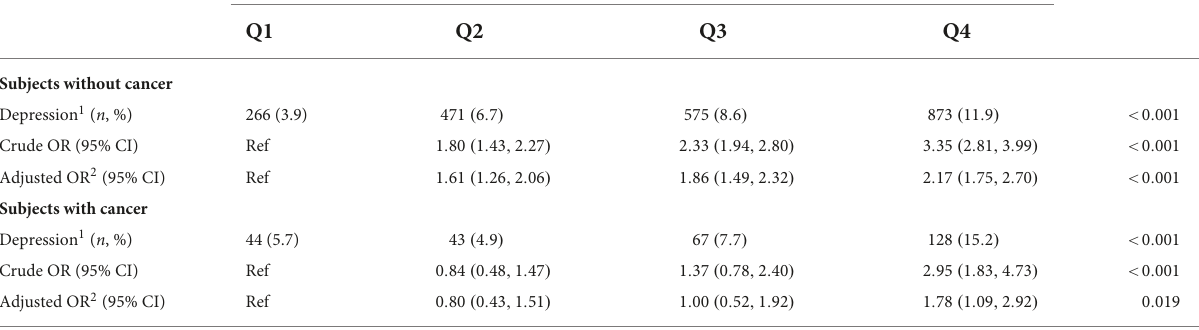
TABLE 2 Association between dietary inflammatory index score and depression status across cancer status and cancer related variables in NHANES 2007–2018. Dietary inflammatory index score (quartiles) P trend